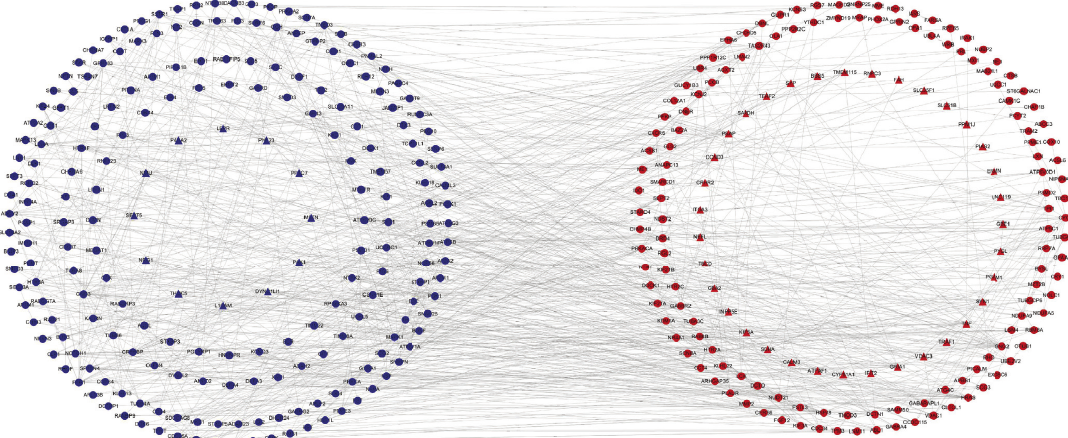
Figure 5: PPI network of DEGs. Blue represents downregulated genes, red represents upregulated genes, and the genes represented by triangles have more significant differences in gene expression than those represented by